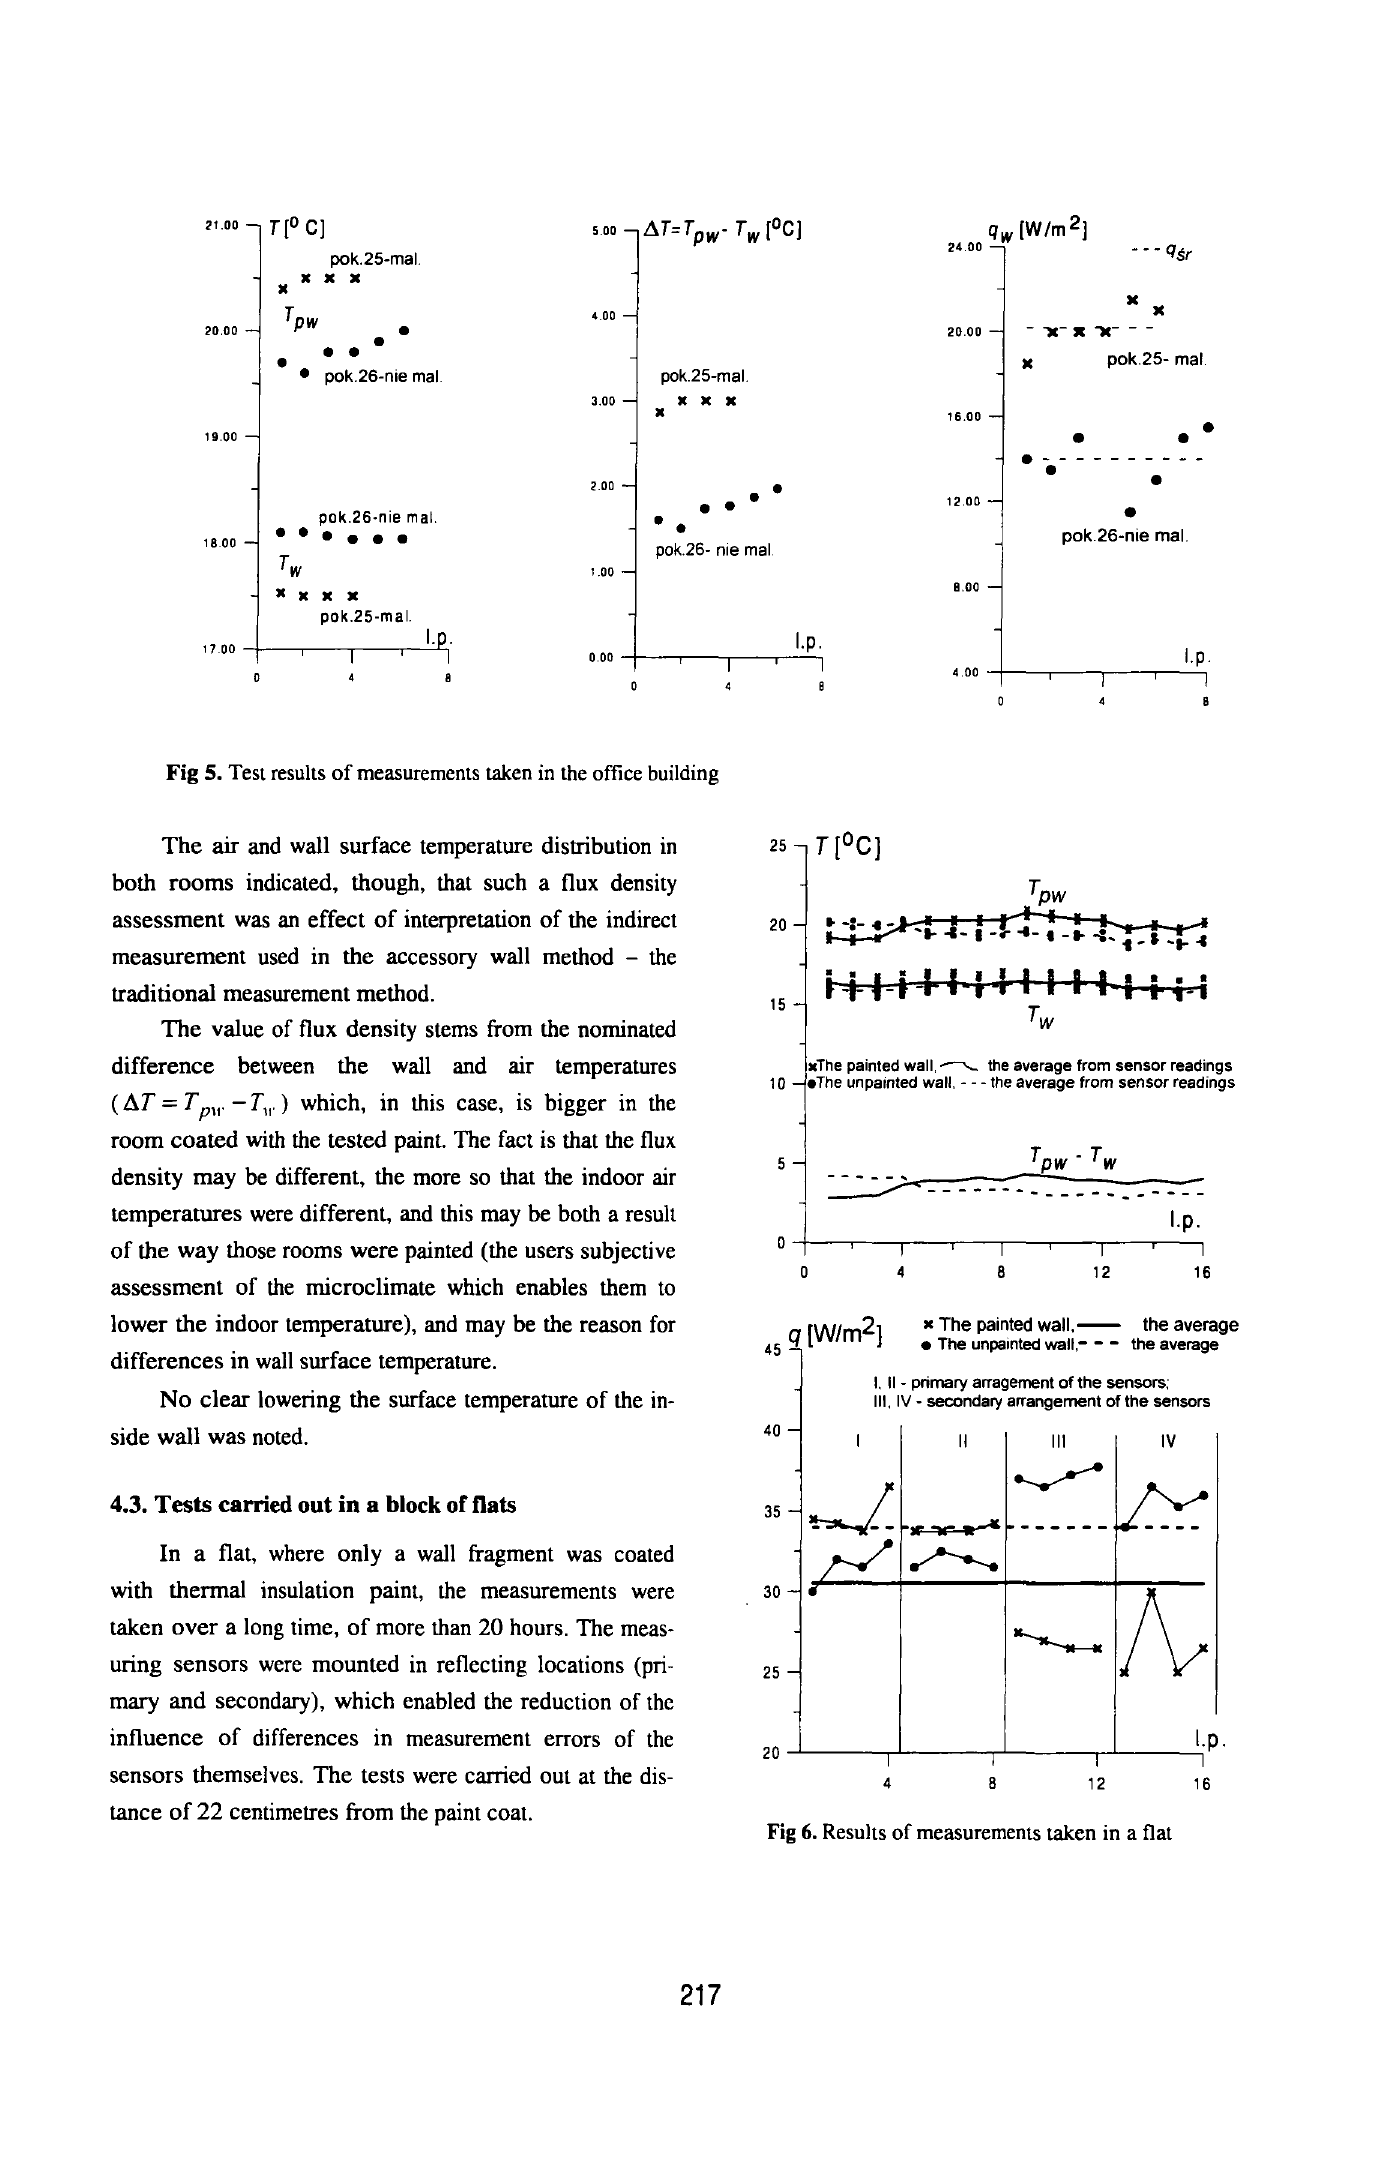
Fig 5. Test results of measurements taken in the office building